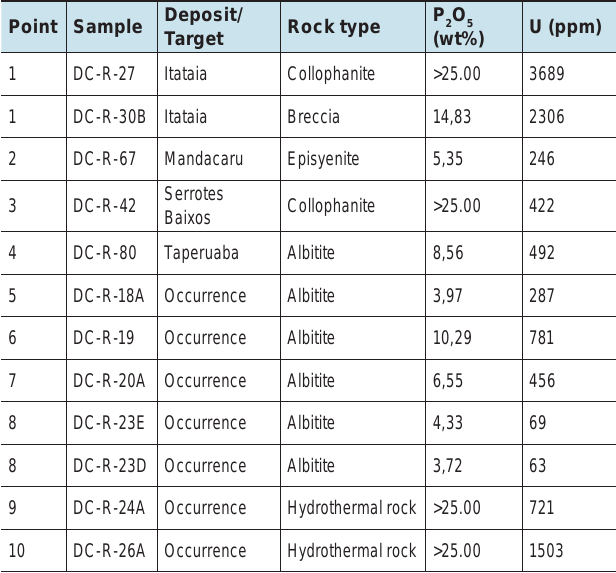
Table 2 - Chemistry analysis of targets samples (compiled from Santos et al. 2014).